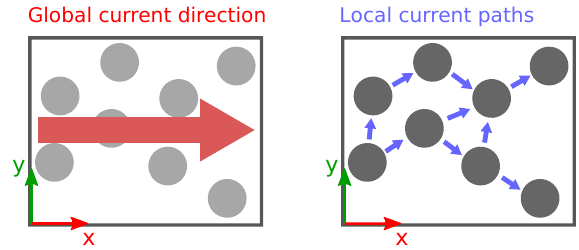
Figure 7. Directions of local current flow in a hexagonal particle arrangement. For a global current in the x direction, particle-to- particle currents have an x and y component, leading to transverse sensitivity.